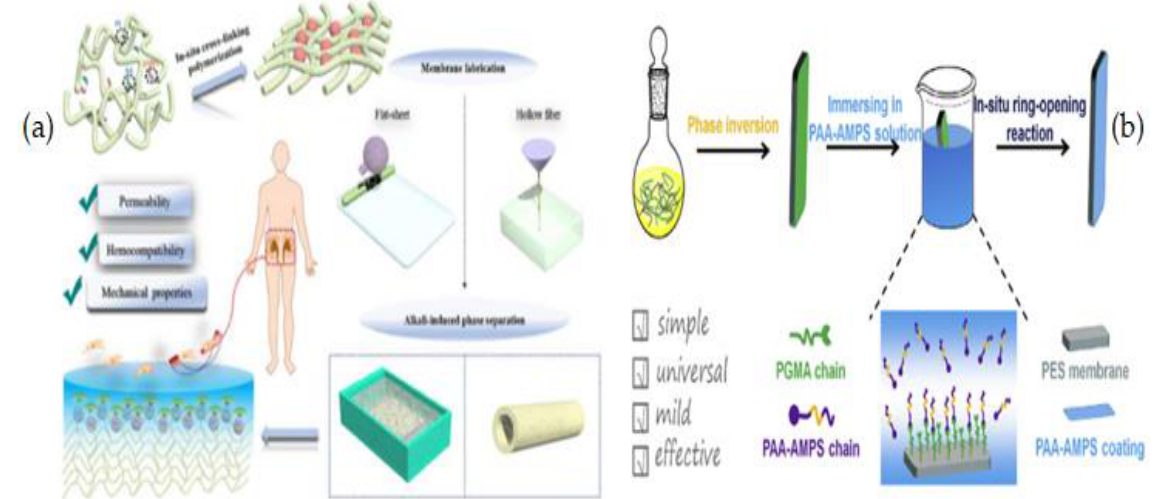
Figure 13. ( a ) Synthesis of heparin-mimicking semi-interpenetrating PES membranes via in situ cross-linked copolymerization [44], ( b ) Synthetic procedure of ES/GMA/PAA-AMPS membranes [201].